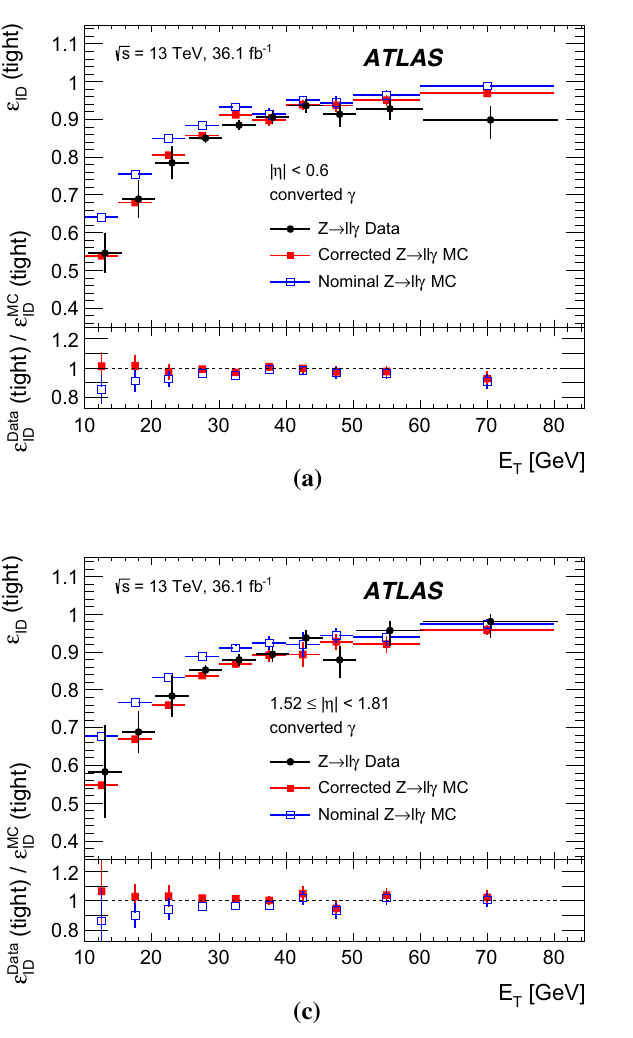
Fig. 10 Comparisonofthemeasurementsofthedata-drivenidentifica- tion efficiency for converted photons measurements obtained using the radiative Z method with the predictions from Z → (cid:4)(cid:4)γ simulation as a function ofphoton E T ,for thefourpseudorapidity intervals a | η | < 0 . 6, b 0 . 6 ≤ | η | < 1 . 37, c 1 . 52 ≤ | η | < 1 . 81, and d 1 . 81 ≤ | η | < 2 . 37.